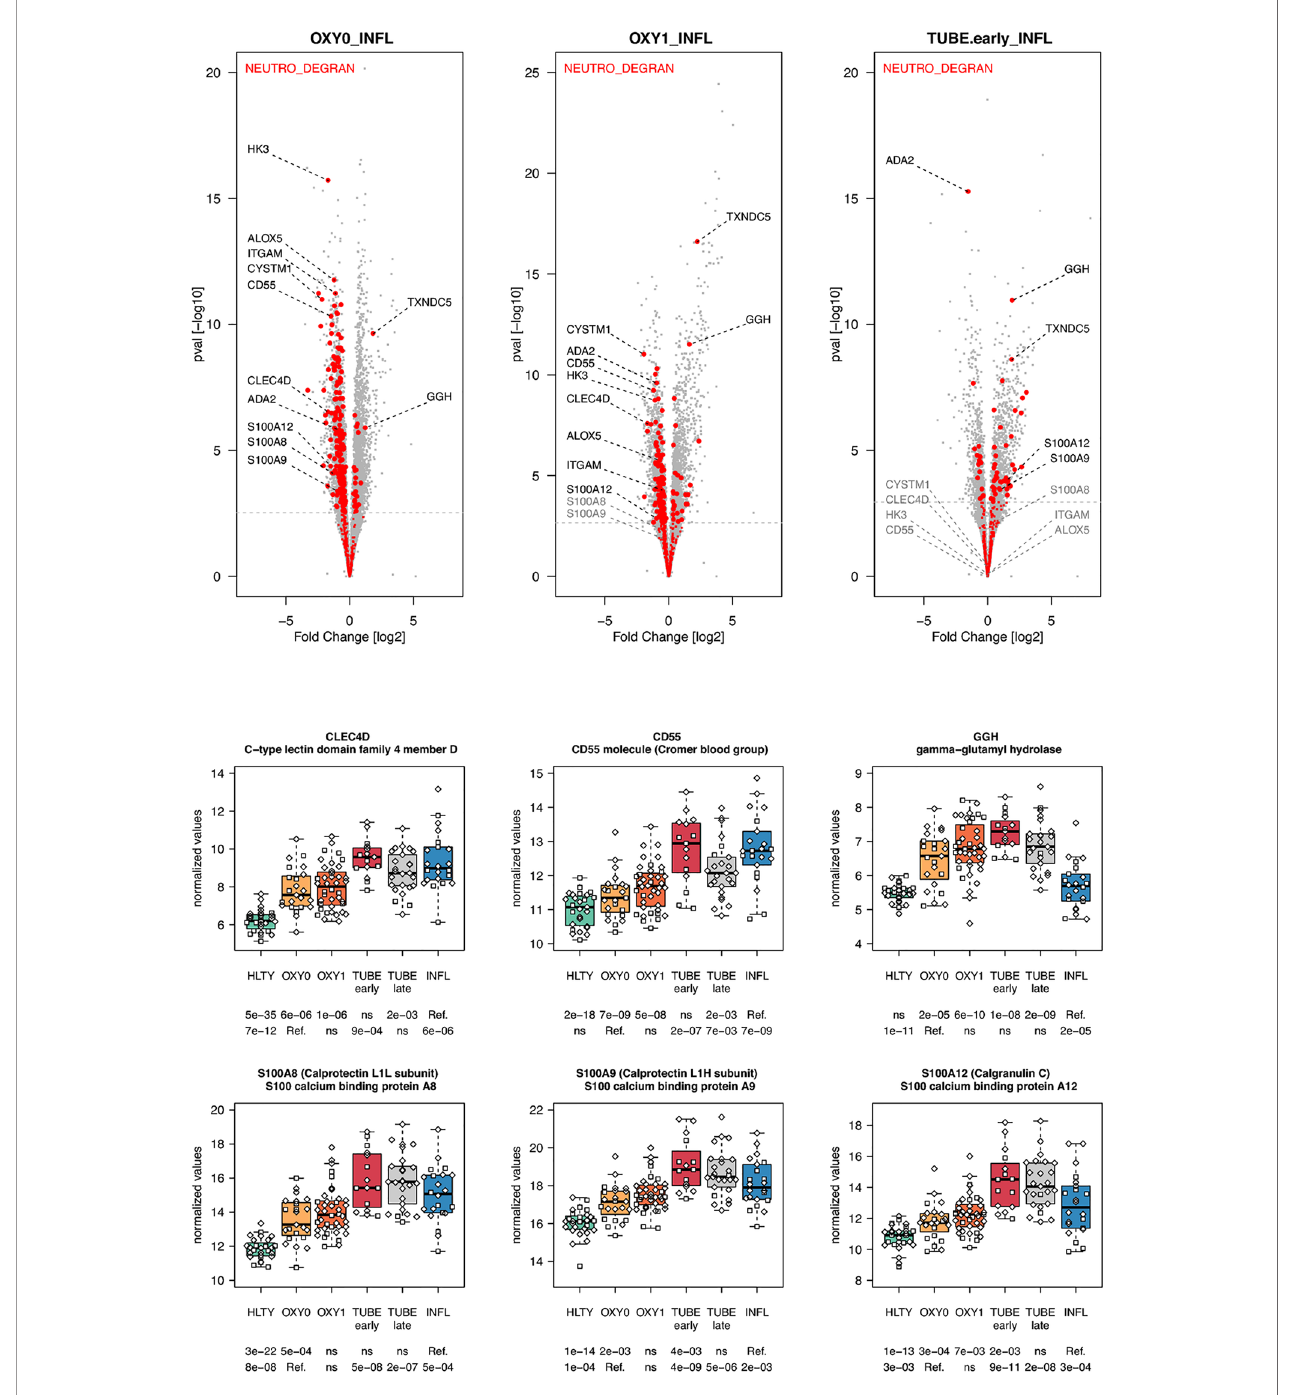
FIGURE 6 | Differentially expressed genes (DEGs) involved in macrophages and neutrophils functions. Upper panel: for each comparison indicated in the volcano plot header, the distribution of log2 fold changes and P-values of all detected genes is shown as gray dots. Red dots indicate genes involved in neutrophils degranulation. Genes ’ sets are selected from different GO, REACTOME and/or KEGG pathways (see Supplementary Table 2 ). The dotted horizontal gray line indicates the limit under which – log10(P-value) becomes non signi fi cant once adjusted for multiple testing (adjusted P > 0.01). Lower panel shows detailed expression levels of selected genes involved in macrophages function and neutrophils degranulation in the different groups of patients. Groups used for comparisons include SARS-Cov-2 infected patients (no oxygen support [OXY0], oxygen support [OXY1], intubation with sampling within 7 days [TUBE early] or >7 days [TUBE late] after hospital admission), In fl uenza virus [INFL] infected patients and non-infected controls [HLTY]. Adjusted P-values of pairwise comparisons between a reference group (Ref.) and another group are indicated below the x axis. Ref. is taken as [INFL] and [OXY0] on the fi rst and second line,